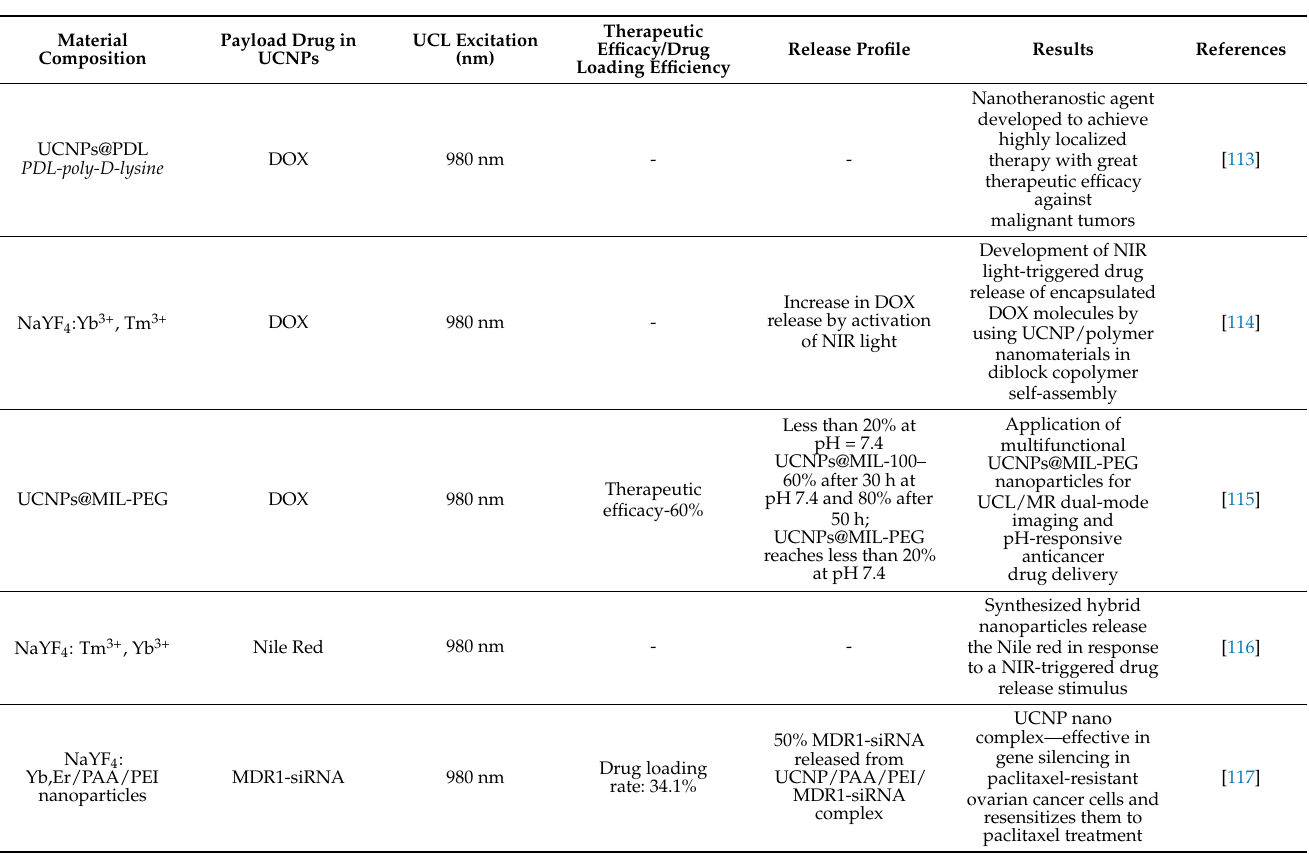
Table 4. UCNPs in drug